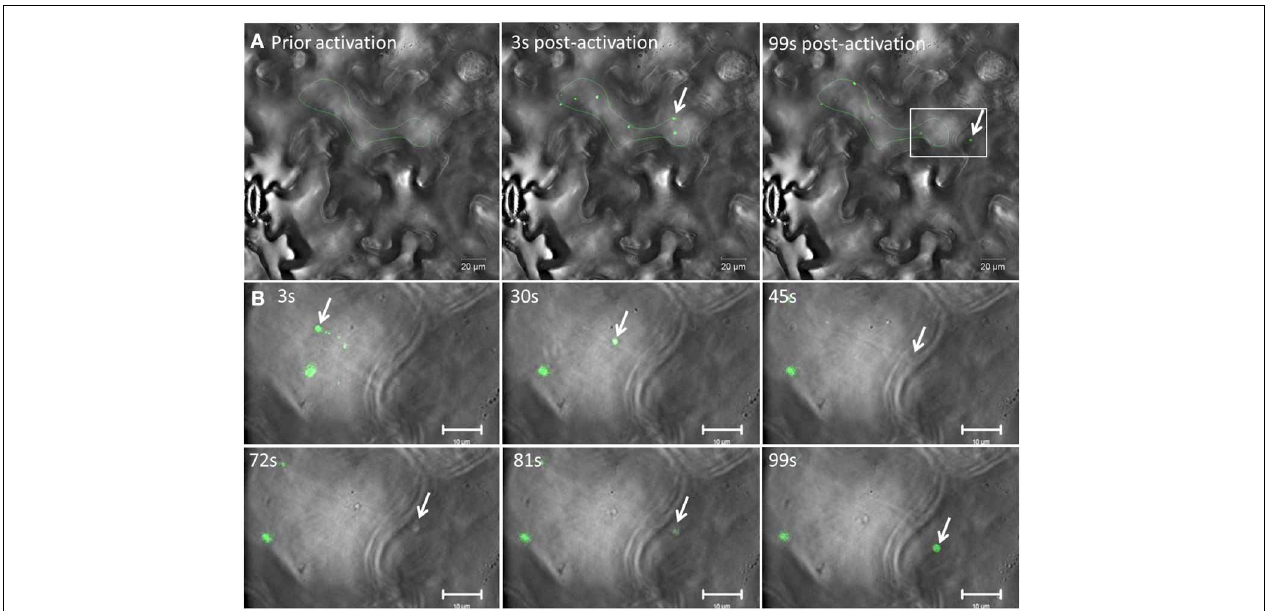
FIGURE 5 | TuMV-induced 6K 2 -tagged vesicle moves intercellularly. (A) Time series images of a photoactivated cell infected with TuMV producing 6K 2 :mCherry-tagged vesicles and expressing 6K 2 :PAGFP. The red channel is not represented. Left panel shows a cell prior to photoactivation, middle panel shows a cell 3 sec after activation using a 405nm diode. Right panel shows a cell 99 sec after activation. Green line indicates activation area.